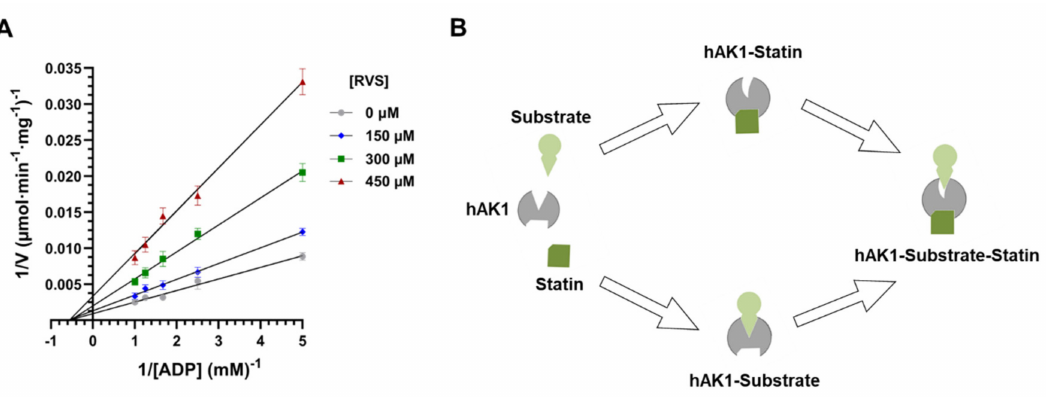
Figure 6. ( A ) Double reciprocal plots of hAK1 inhibition by rosuvastatin (RVS). ( B ) A graphical presentation of hAK1 noncompetitive inhibition by